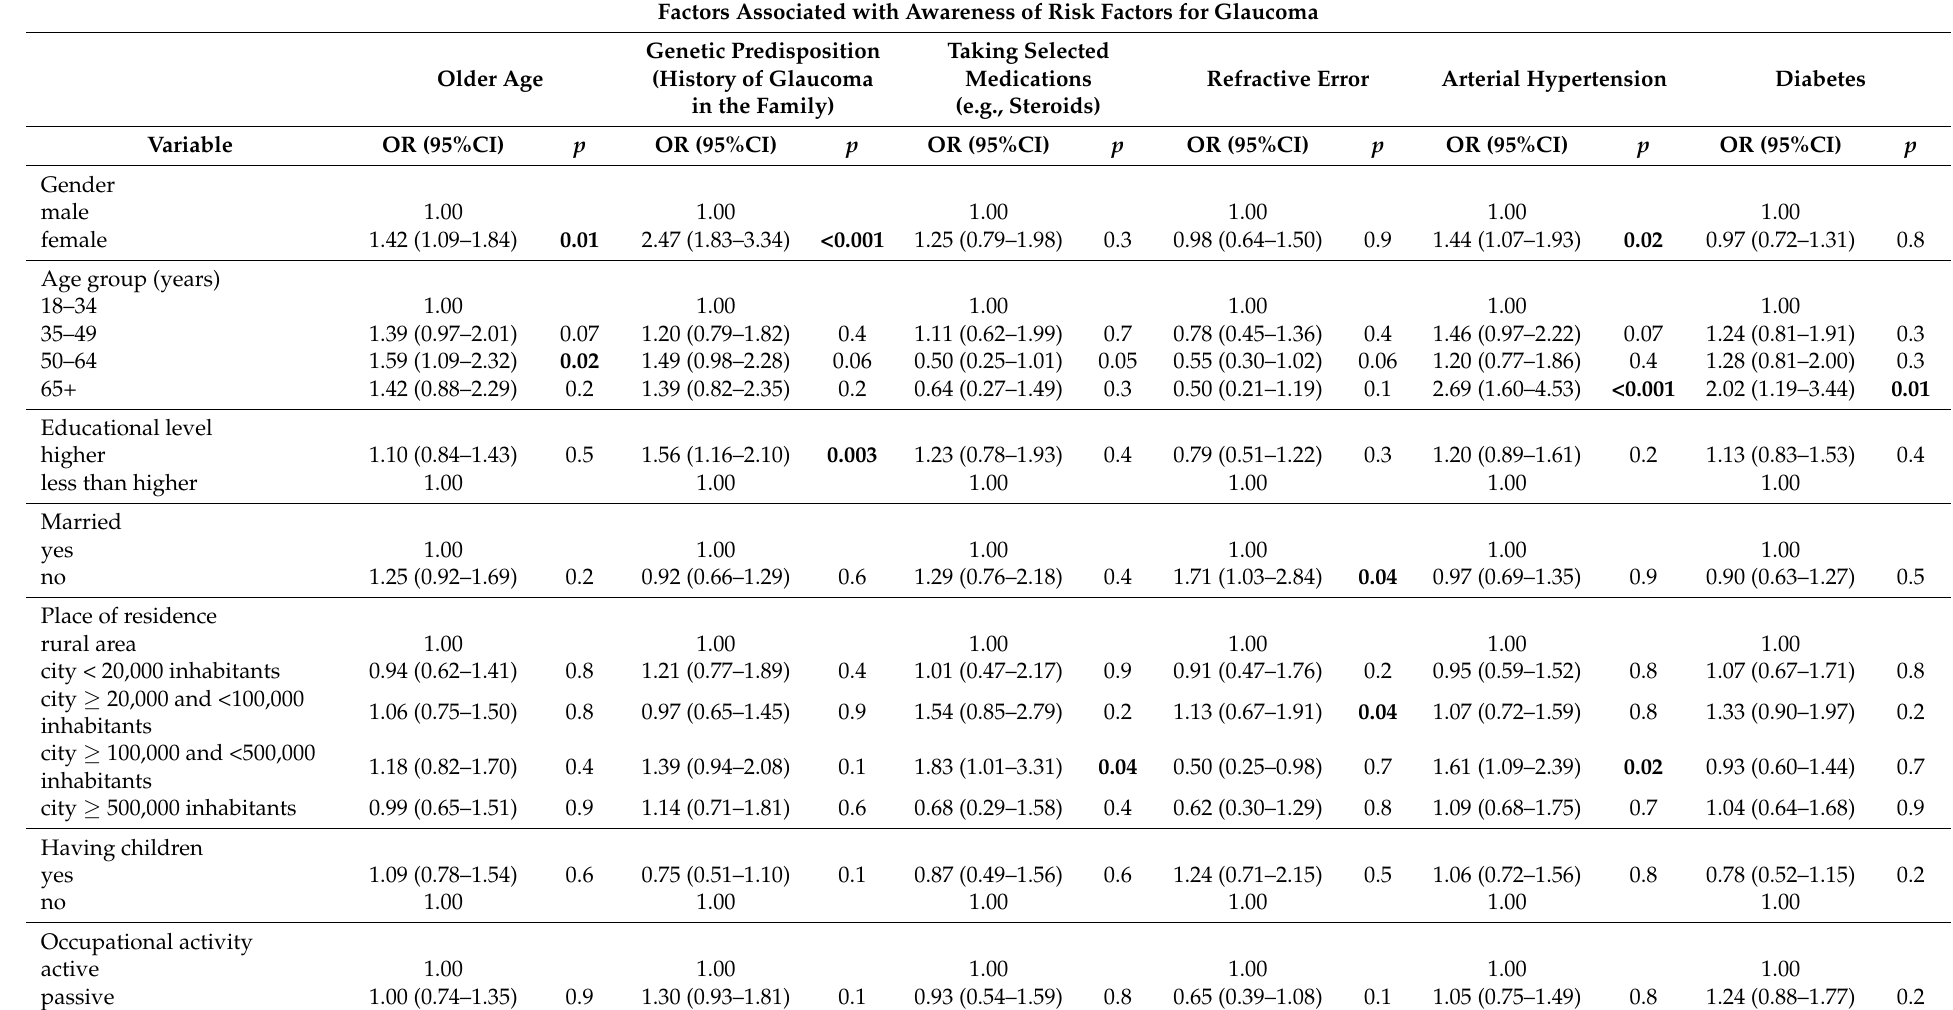
Table 7. Factors associated with awareness of risk factors for glaucoma (n = 1076). Factors Associated with Awareness of Risk Factors for Glaucoma Genetic Predisposition Taking Selected Older Age (History of Glaucoma Medications Refractive Error Arterial Hypertension in the Family) (e.g., Steroids)